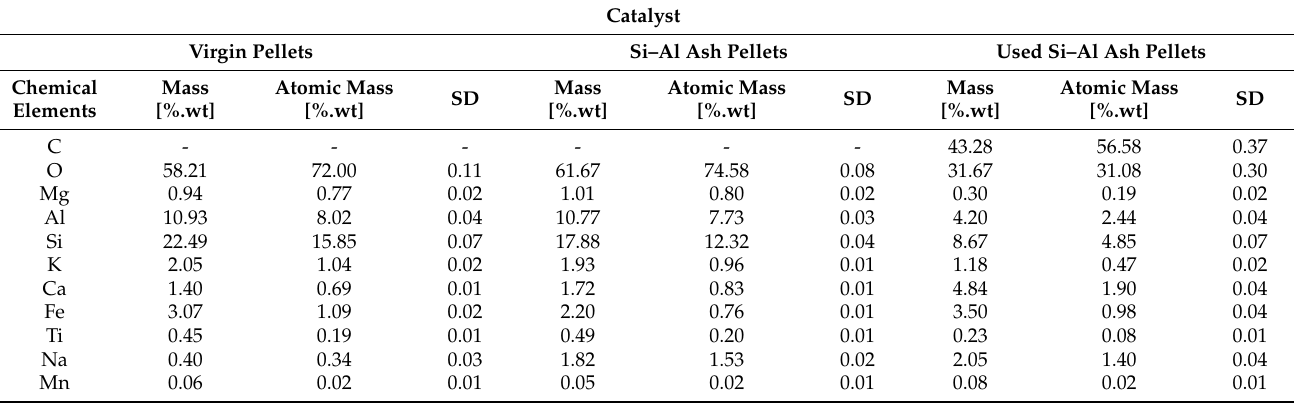
Table 2. Percentages in mass and atomic mass of virgin pellets, Si–Al ash pellets, and pellets after upgrading